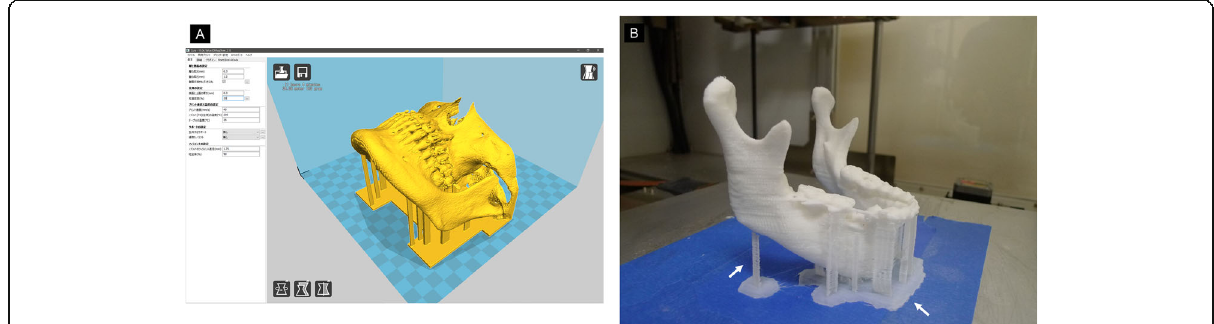
Fig. 3 3D CAD model as displayed in 3D printer slicing software “ CURA. ” Arrows indicate support structures for increasing the fabricating stability. The ease of removal of the support structures changes depending on the printing parameter setting and the installation position